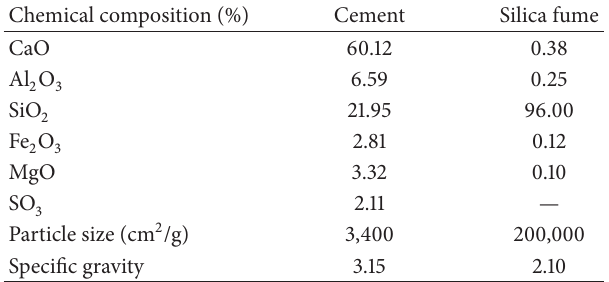
Table 1: Chemical composition and physical properties of cement and silica